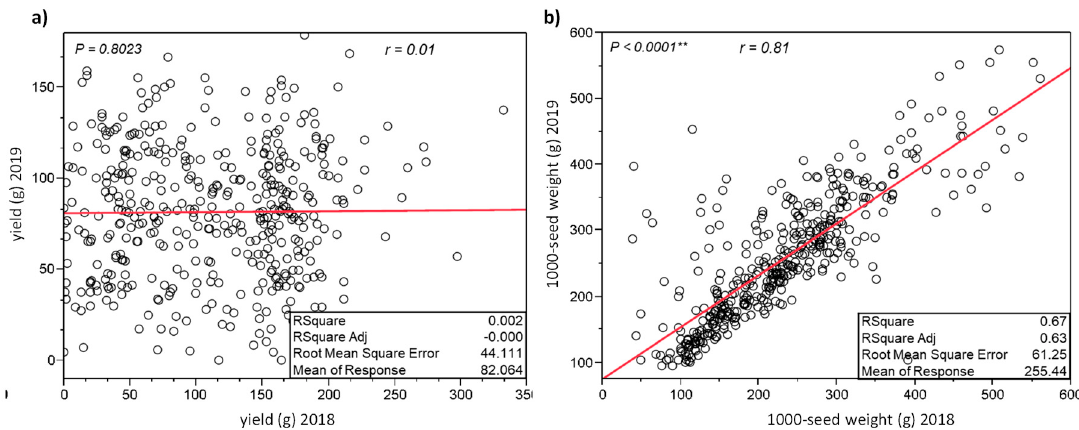
Figure 10. Correlated responses for the production traits of yield ( a ) and 1000-seed weight ( b ). Scatterplots of the production traits from year 2018 and 2019. Linear regressions are highlighted in red. The regression coefficient estimates the narrow sense heritability for the related trait.